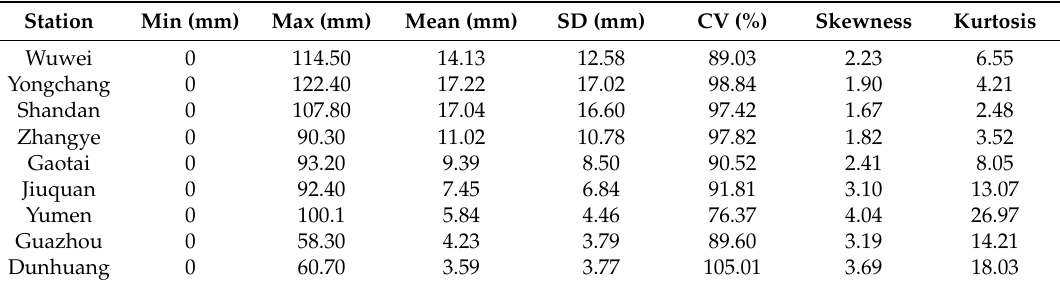
Table 3. Statistical parameters of monthly precipitation at the meteorological stations during the period